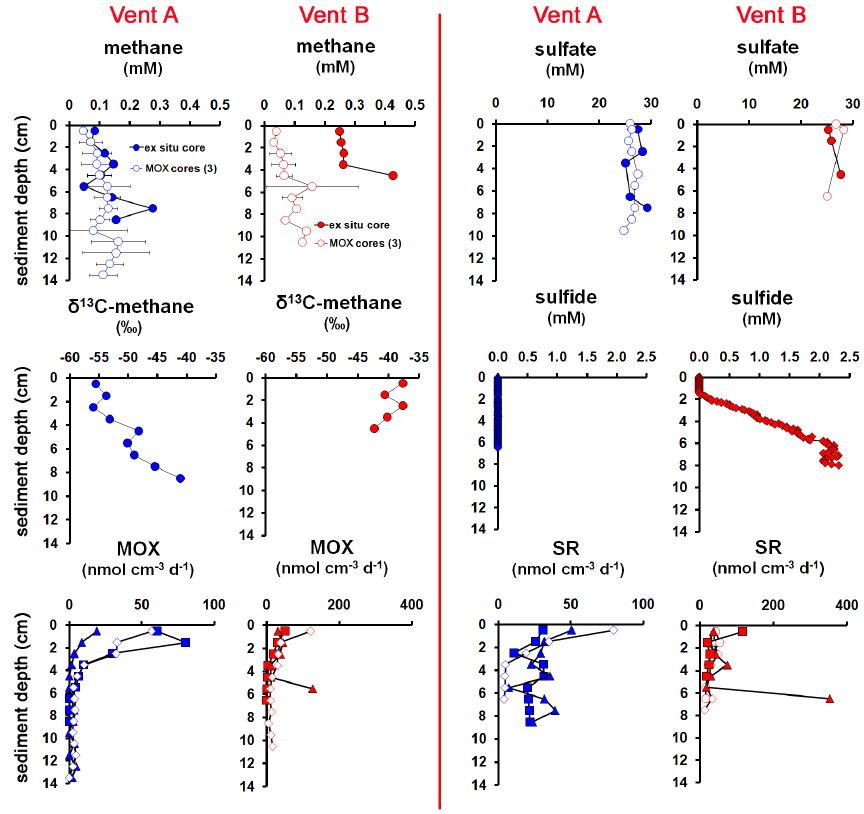
Fig. 3b. Biogeochemical profiles of the June sampling at Brian Seep: methane, δ 13 C-methane, methane oxidation (3 replicates), sulfate, sulfide, and sulfate reduction (3–4 replicates). Methane profiles show methane concentrations of samples taken immediately after recovery (ex-situ core) or after 24h incubation (MOX cores, no. of replicates provided in legend). Methane concentrations are presented in mmolL − 1 sediment. Cores were sampled close to gas vents: Vent A (blue) and B